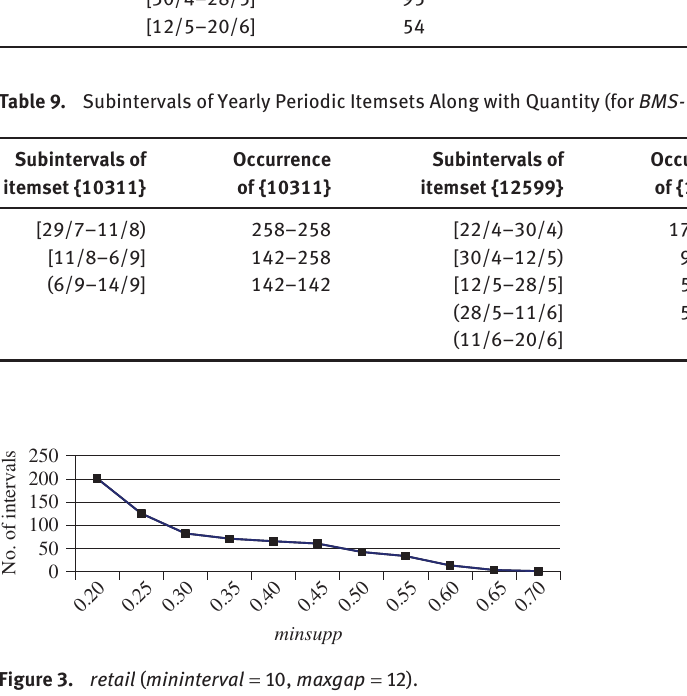
Figure 3. retail ( mininterval = 10, maxgap = 12).